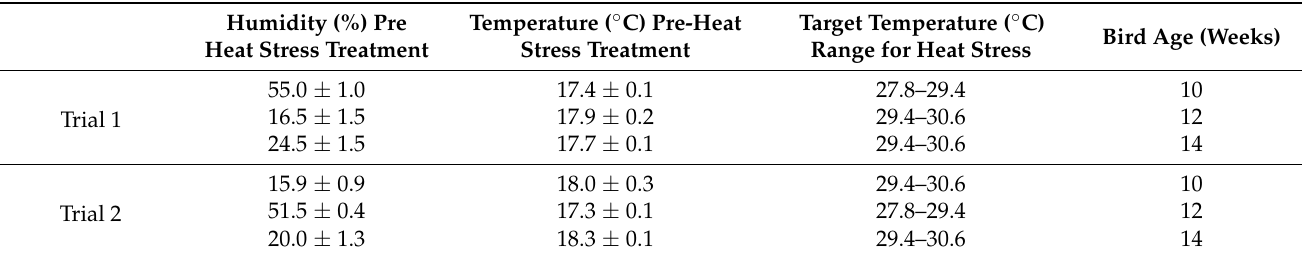
Table 2. Average ( ± SD) humidity and temperature ranges during Trial 1 and Trial 2 at each age, recorded 10 min prior to heating the rooms. Target temperature ranges were derived from Xin and Harmon [26].